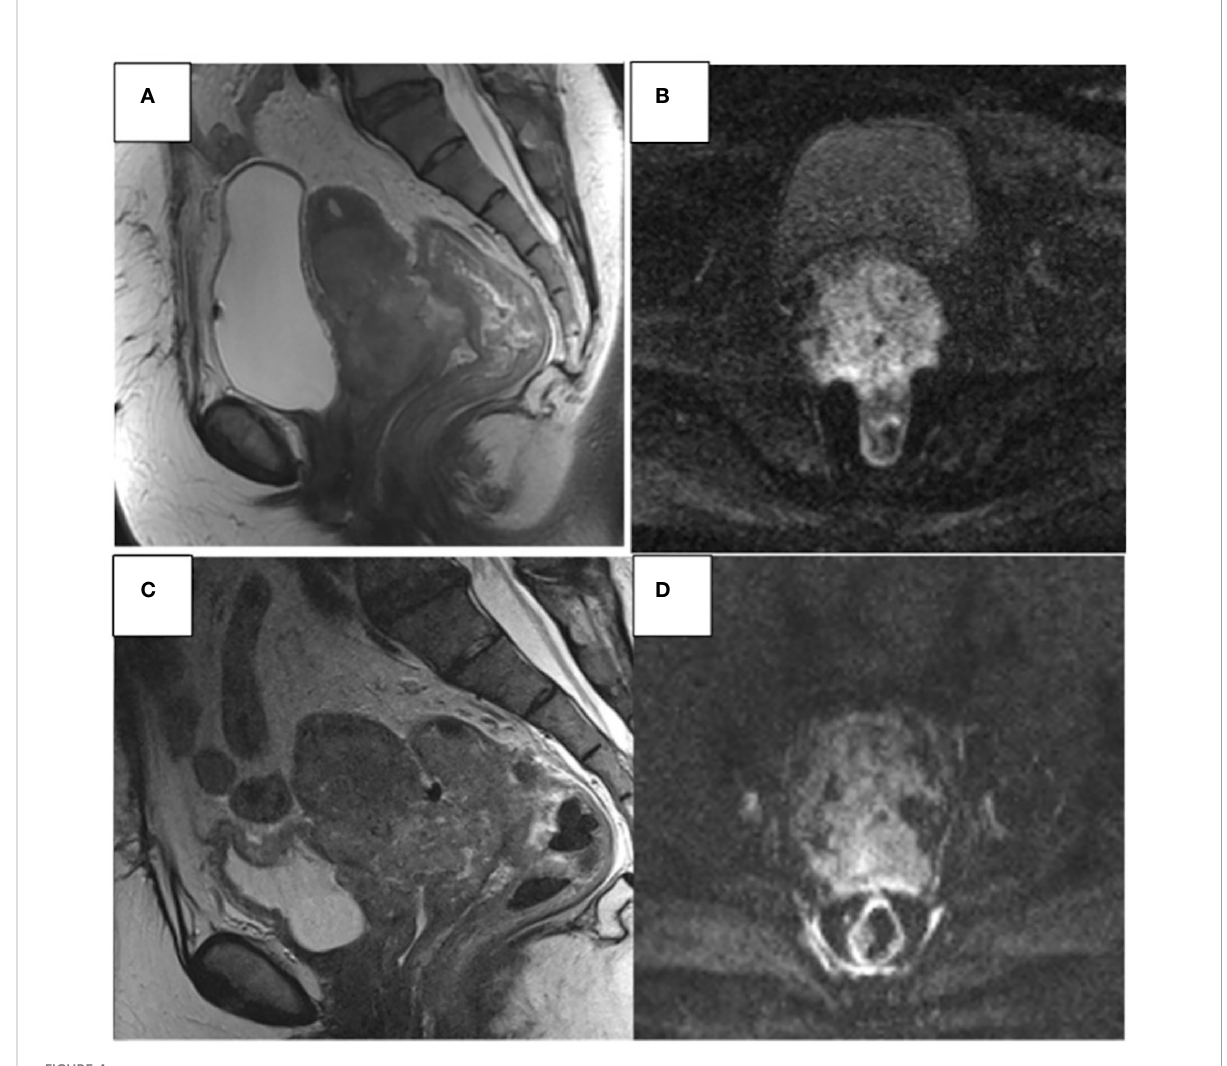
FIGURE 4 67- year-old woman. Sagittal T2W and axial DWI MR images show an invasive CC (A, B) . Progression disease (C, D) CC in fi ltrates the uterine body, lower 1/3 of the vaginal canal, mesorectum, anterior wall of the rectum, and posterior wall of the